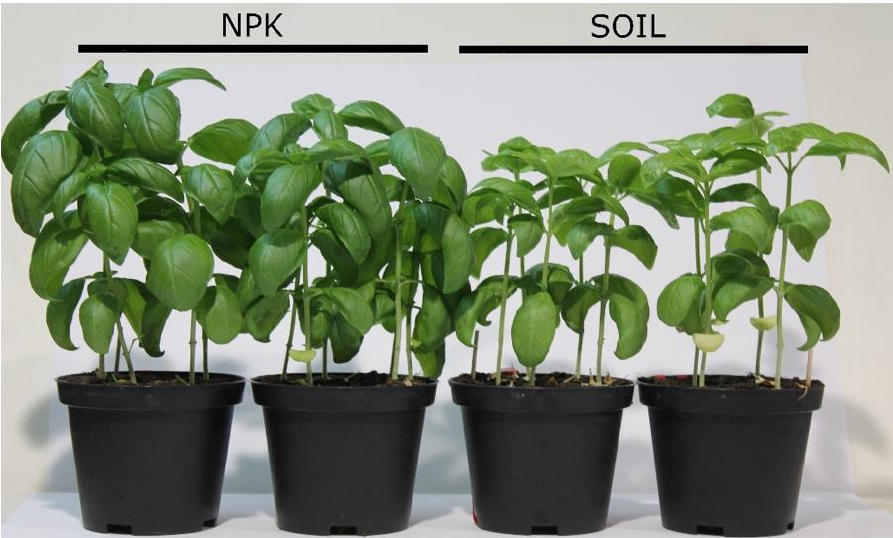
Figure 5. Basil plants obtained under 3HR:1DB LED lights.